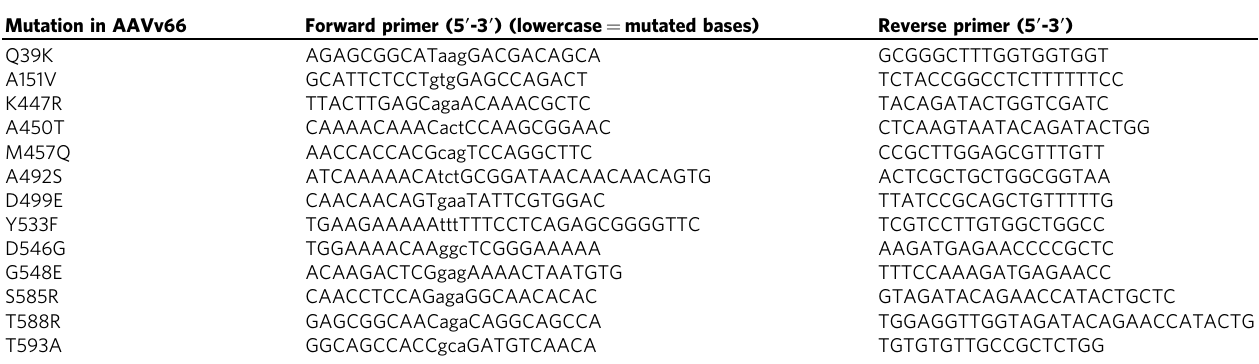
Table 1 Primer pairs for site directed mutagenesis to generate point mutations in the AAVv66 capsid ORF. Mutation in